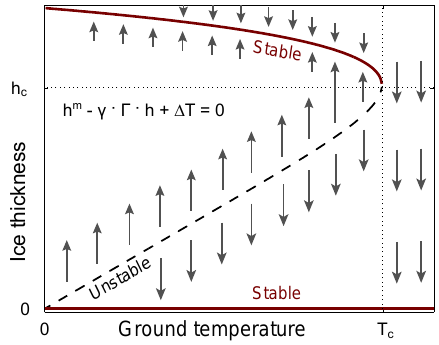
Figure 1. Ice sheet hysteresis. If the ice sheet is in an unstable con- figuration (dashed black branch), a slight perturbation will either cause it to converge into the stable state (upper red branch) or to melt completely. For a given temperature, the dotted line gives the critical surface elevation (Sect. 3). If the surface elevation is lower than h c , a complete meltdown of the ice sheet is inevitable. Once the temperature threshold, T c , is crossed, the time for a collapse of a certain fraction of the ice sheet can be estimated via Eq.